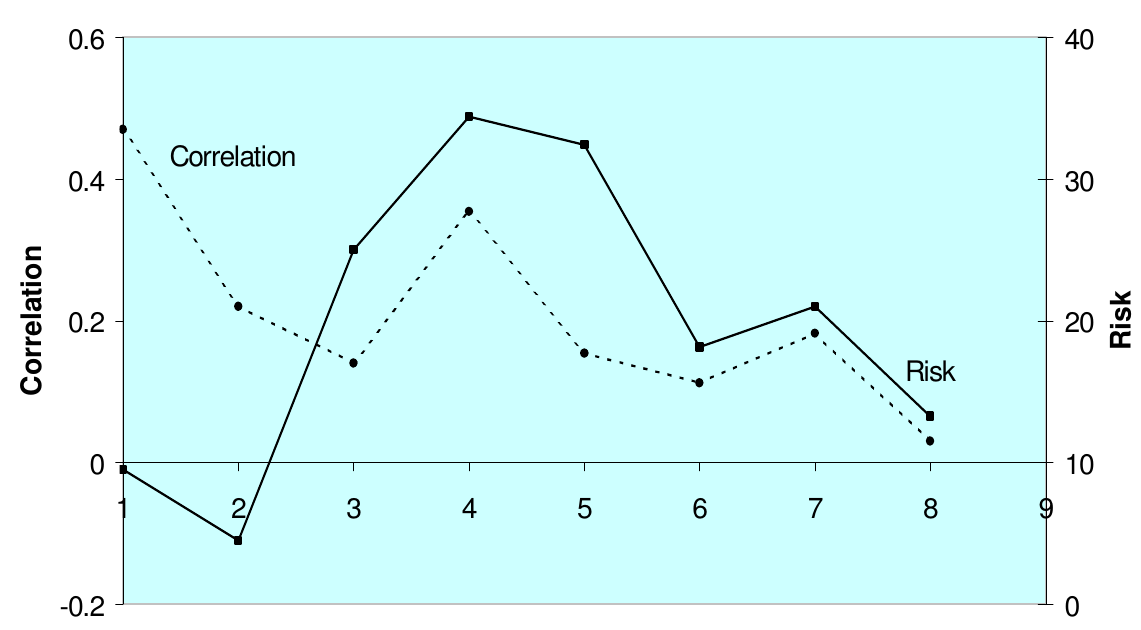
Figure 6: JSE risk vs